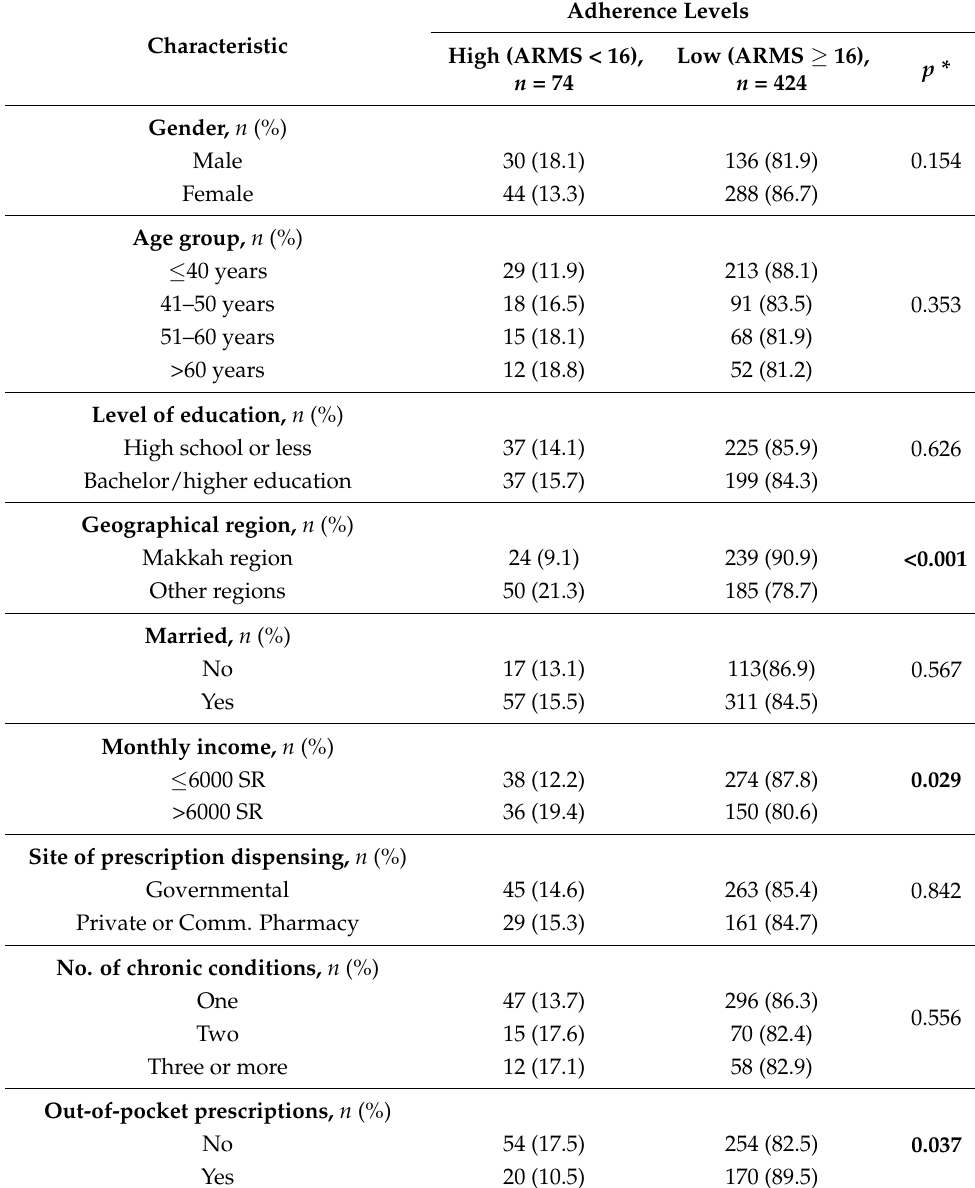
Table 2. Characteristics of patients according to their levels of adherence.